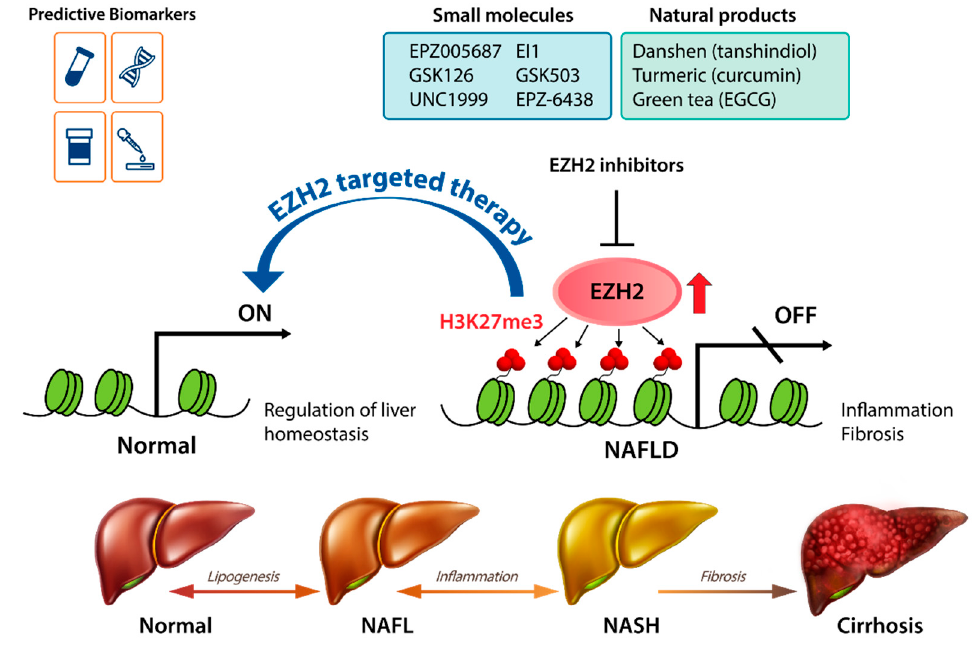
Figure 2. EZH2 as a therapeutic target in NAFLD. Abnormal activation of EZH2 may drive NAFLD progression, and EZH2-targeted therapy could be a promising strategy for NAFLD. A major class of small-molecule inhibitors of EZH2 is the SAM-competitive inhibitors, such as EPZ005687, EI1, GSK126, UNC1999, GSK503, and EPZ-6438. Natural products such as tanshindiols (the major active components of danshen), curcumin (a natural polyphenol from turmeric), and epigallocatechin-3-gallate (EGCG, the major chemical constituent of green tea) have EZH2-inhibiting activity. Development of predictive biomarkers to select patients suitable for EZH2-targeted therapy will improve the efficiency of this approach.